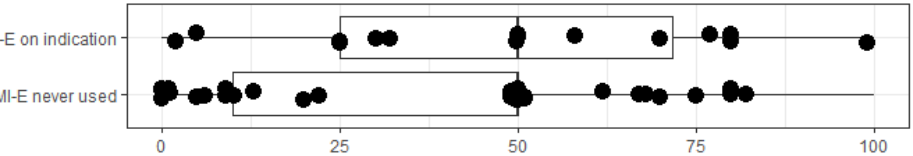
Figure 2. Perceptions of efficacy and safety of airway care interventions. Respondents could rate their perceptions on safety and efficacy of airway care interventions on a visual analogue scale from 0 (totally disagree) to 100 (totally agree). Results are grouped by reported intensity of use in their ICU.